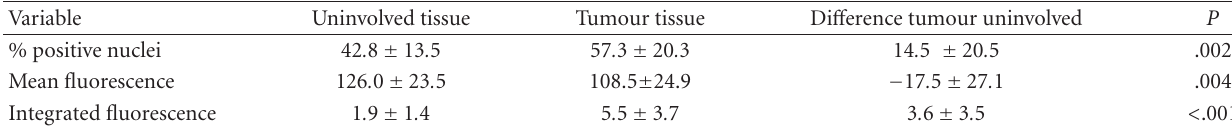
Table 2: MGMT content in bladder tumours and uninvolved tissues measured by quantitative